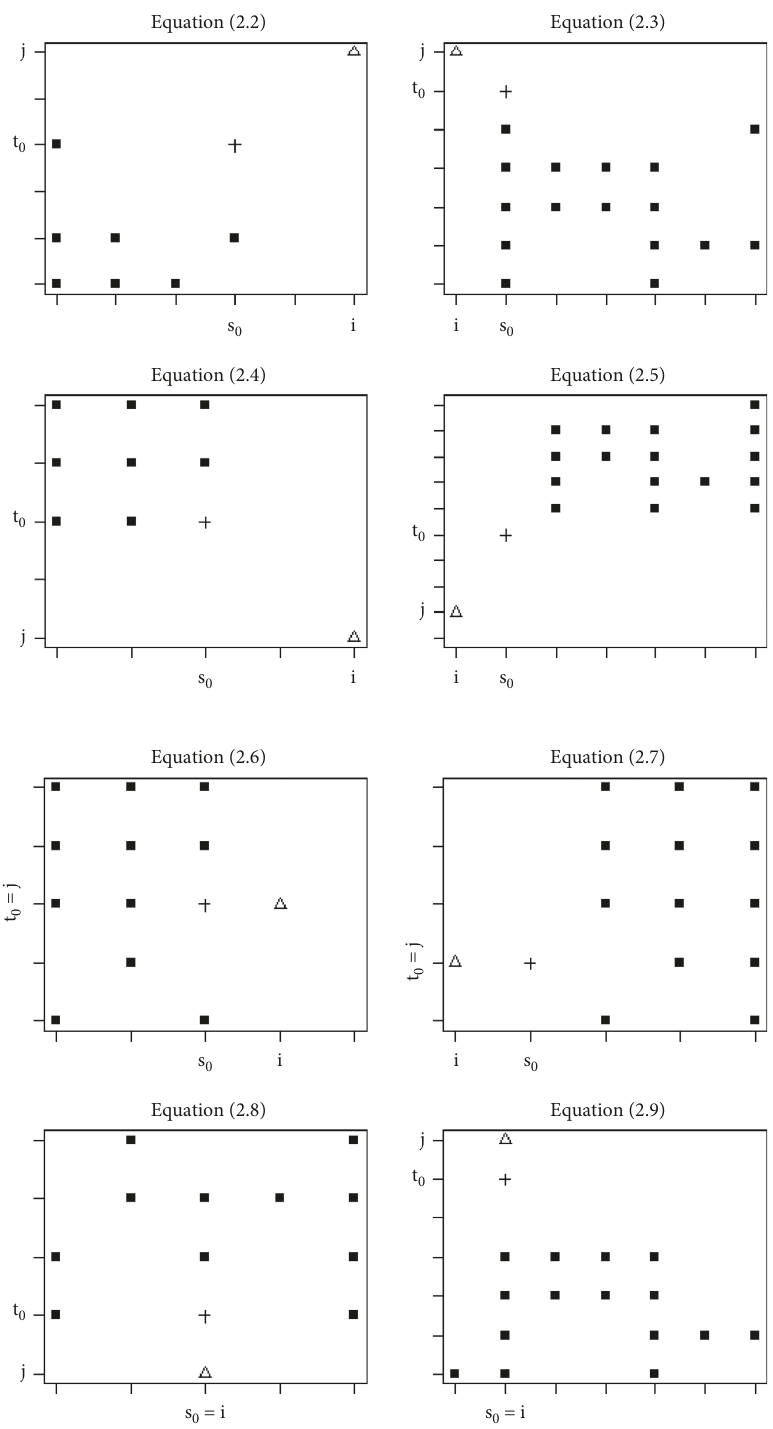
Figure 2: Locations of neutralized observations ( △ ) , neutralizing observation (+), and missing value ( ■ )